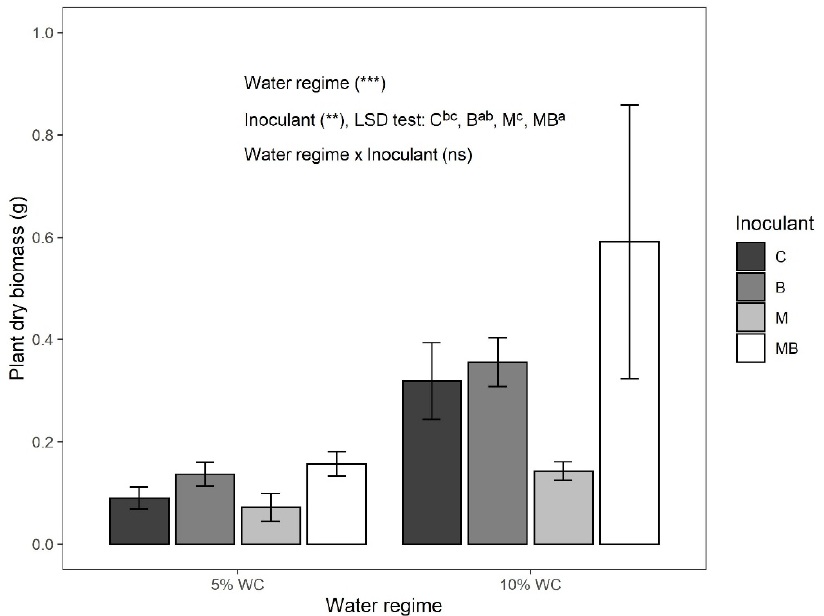
Figure 1. Mean values (±SE) of dry biomass (g) of Lactuca sativa plants grown under different water regimes. In the case of significant effects (** p < 0.01, *** p < 0.001), the results of the post hoc comparisons are presented; different superscript letters denote significant differences (C = Control, B = B. subtilis , M = AMF, MB = AMF and B. subtilis ).